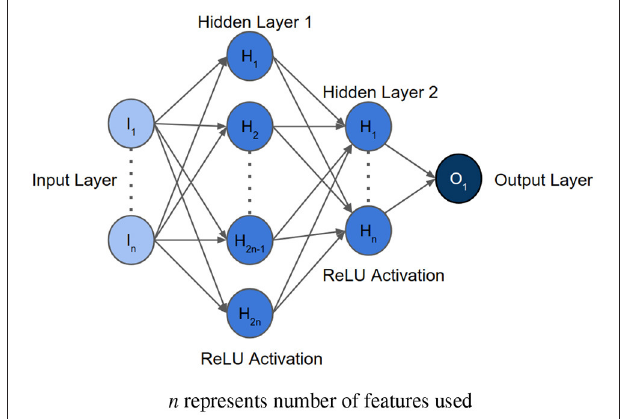
FIGURE 3 | Architecture of the neural network implemented for feature selection, where n represents the number of features to be analyzed.